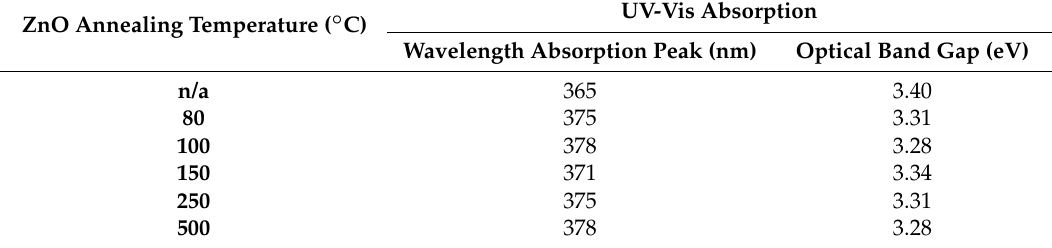
Table 2. Absorption peak position and the optical band gap energy of the ZnO samples before and after annealing at different